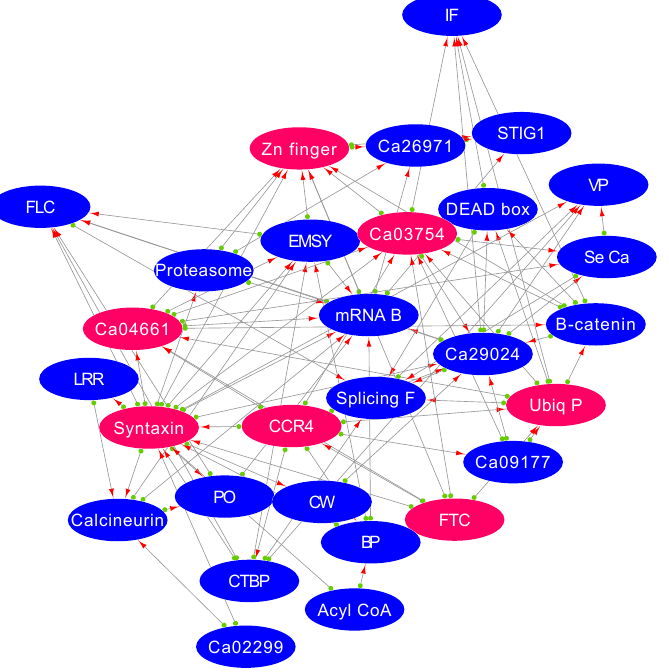
Figure 7. Weighted gene co-expression network analysis (WGCNA) shows gene signalling pathways involved in flowering time control response to salt stress. CW: cell wall genes; PO: polyamine oxidase; SeCa: serine carboxypeptidase; BP: mRNA binding protein, CCR4: CCR4-NOT transcription complex, IF: initiation factor; VP: vesicle protein, FTC: flowering time control; mRNA B: mRNA binding protein; CTBP: carboxy-terminal binding